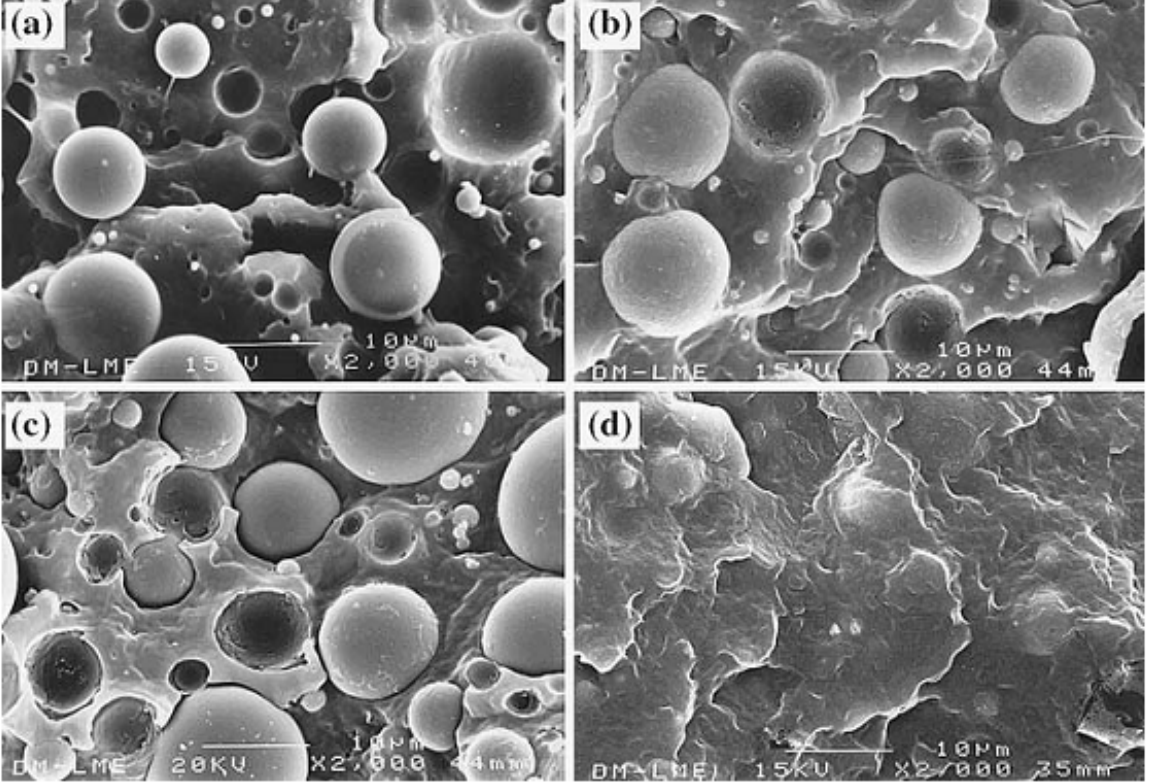
Figure 17. Degrees of interfacial adhesion achieved by the modification of the glass bead surface and the polarity of PP matrix. (a) Low adhesion, (b) and (c) medium adhesion, (d) high adhesion (adapted from [40]).